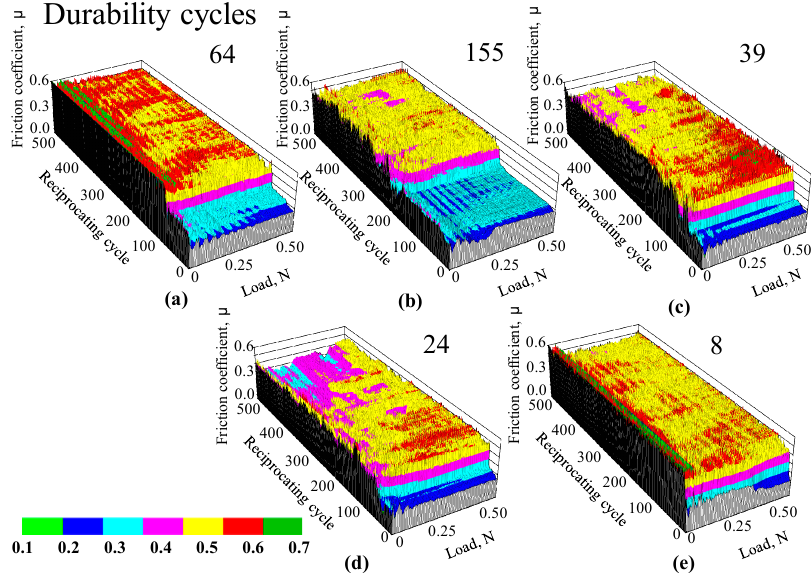
Figure 12. Friction coefficient of 1.0 nm thick ECR-CVD-DLC film after heat treatment. ( a ) RT; ( b ) 100 °C; ( c ) 200 °C; ( d ) 300 °C; ( e ) 500 °C.